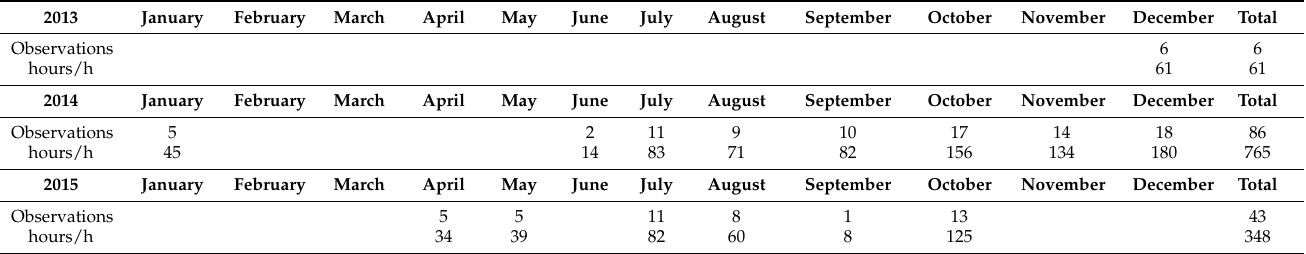
Table 1. The monthly distribution of the lidar